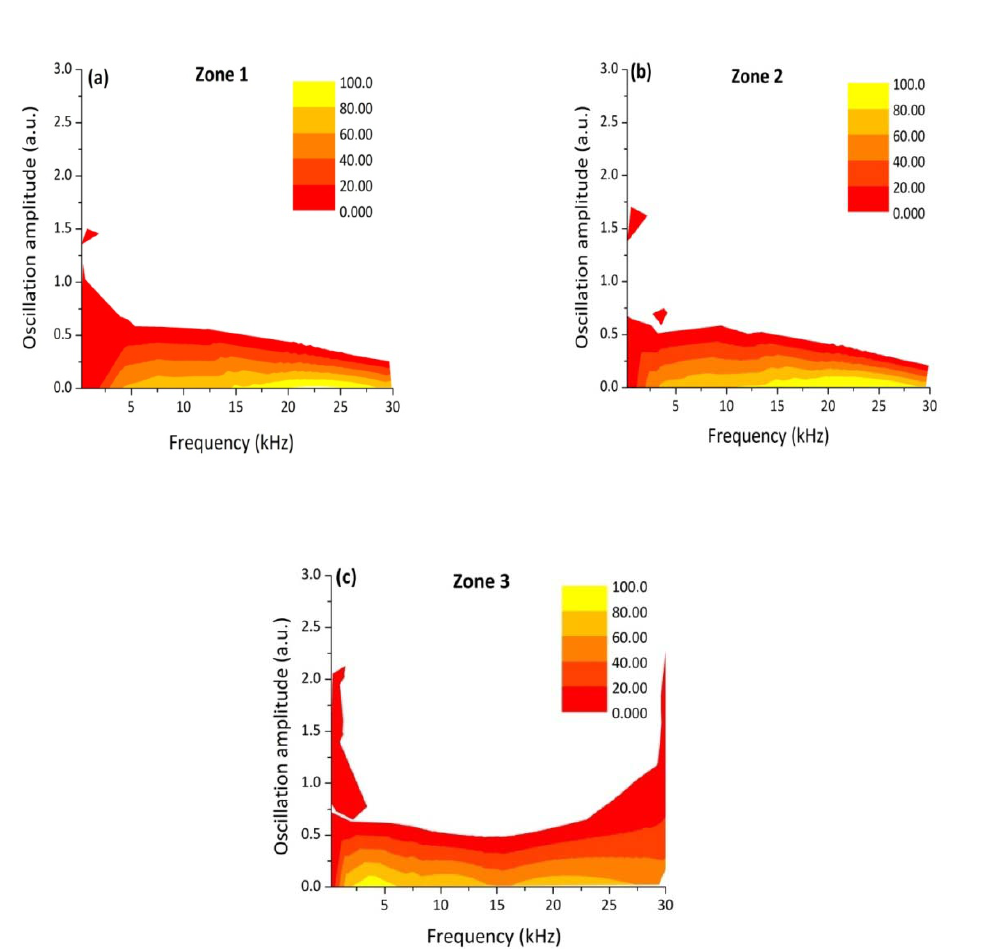
Figure 9. Relative oscillation amplitude of the frequency bands of the photodiode signal acquired during a welding process performed with decreasing laser power (Zone